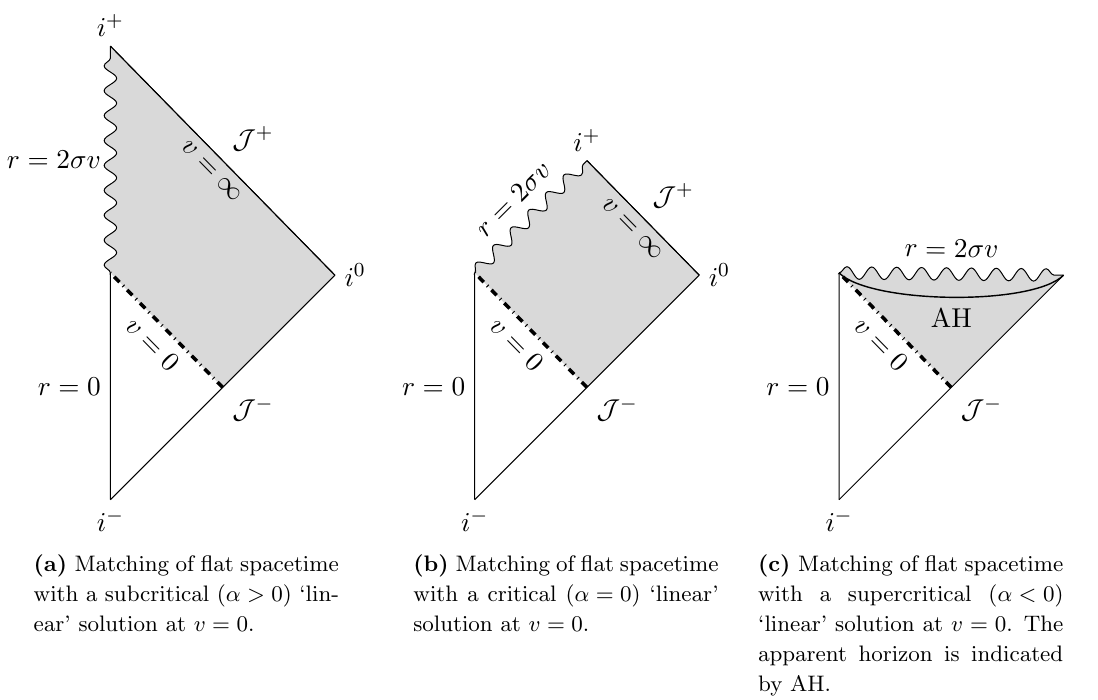
Figure 1 . Carter-Penrose diagrams corresponding to the three qualitatively di(cid:11)erent types of collapse obtained by matching (cid:13)at spacetime to the ‘linear’ CSS solutions sourced by null dust along the null hypersurface v =